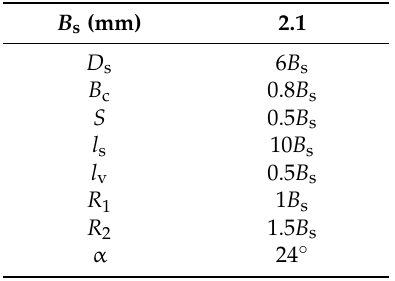
Figure 3. Main geometric parameters of the output-fed bistable fluidic oscillator; B s —width of the supply nozzle; D s —depth of the supply nozzle; B c —width of the control nozzle; S —setback of the attachment wall; l s —nozzle-to-splitter distance; l v —vent-to-splitter distance; R 1 —radius of concave arc of the splitter; R 2 —radius of convex arc of the splitter; α —the divergence angle of the attachment wall. Table 1. The specified dimensions of the output-fed bistable fluidic oscillator.